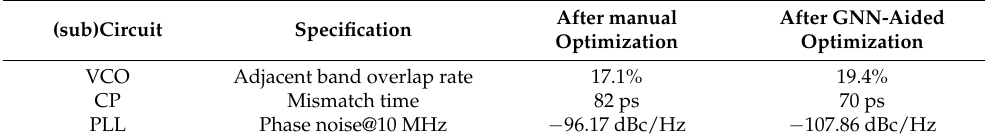
Figure 9. Comparison of optimized charge pumps: ( a ) after manually optimization; ( b ) after pre- diction-based optimization.